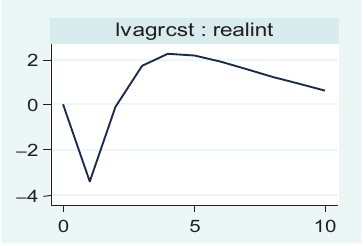
Figure 4. Transmission of real interest rate shocks to agricultural value added in the